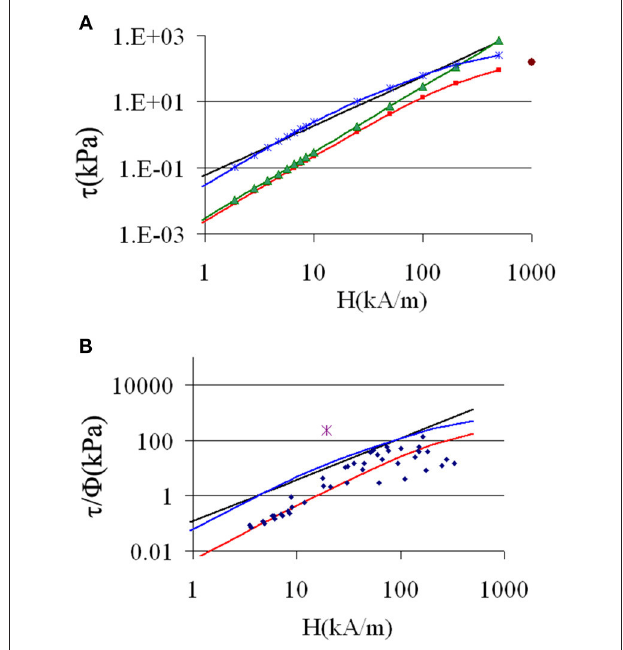
FIGURE 1 | (A) Theoretical yield stress vs. the field acting on the particles. Red squares: calculated from FEMM; green triangles calculated from multipolar forces; black solid line: Equation (6); blue crosses: Equation (7) with F r calculated with FEM. The red dot corresponds to the saturation of the magnetization. (B) Comparison theory-experiment for τ y / 8 . Blue diamonds: experimental points taken from Table S1 . Red line, FEM result; black line, Equation (6); Blue line, Equation (7); Purple star, jamming